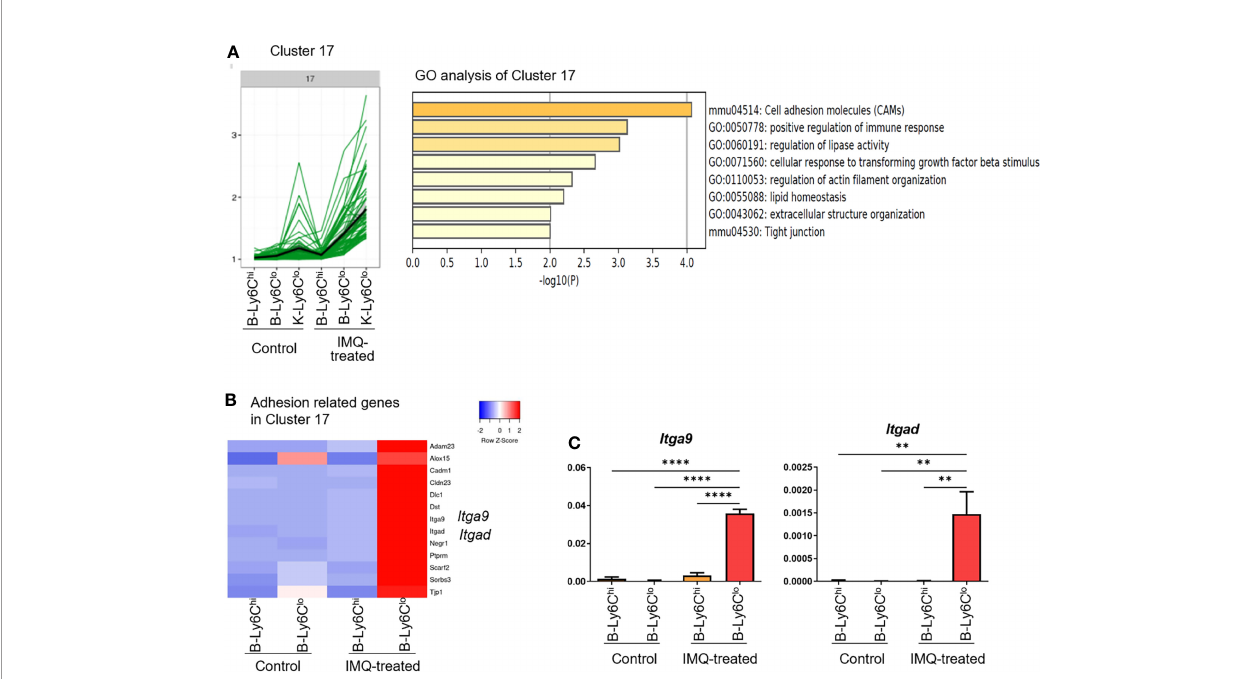
FIGURE 4 | RNA-seq analysis reveals the upregulation of adhesion-related genes in peripheral Ly6C lo monocytes of IMQ-induced lupus mice. (A) In the RNA-seq analysis, cluster 17 among 20 clusters was characterized by genes highly expressed in Ly6C lo monocyte-like cells in the kidneys and Ly6C lo blood monocytes in IMQ-treated mice. Gene ontology analysis revealed adhesion-related genes were enriched in this cluster. (B) Thirteen genes with the gene ontology term “ cell adhesion ” in cluster 17. These genes were upregulated in blood Ly6C lo monocytes from IMQ-treated mice. (C) qRT-PCR analysis of Itga9 and Itgad in blood monocytes. RNA-seq and q-RT PCR results are of pooled samples from four groups of mice each analyzed individually (16 control or 5 IMQ-treated mice were used for each pooled sample in the RNA-seq analysis. Ten control or 3 IMQ-treated mice were used for each pooled sample in the q-RT PCR analysis). In the qRT-PCR analysis, the y-axis shows the fold change expression in comparison with the expression of Gapdh . Bar and horizontal lines indicate the mean and SEM. **P < 0.01 and ****P < 0.0001 by one way ANOVA and post hoc Dunnett ’ s multiple comparison test. B-Ly6C hi ; blood Ly6C hi monocytes, B-Ly6C lo ; blood Ly6C lo monocytes, K-Ly6C lo ; kidney Ly6C lo monocyte-like